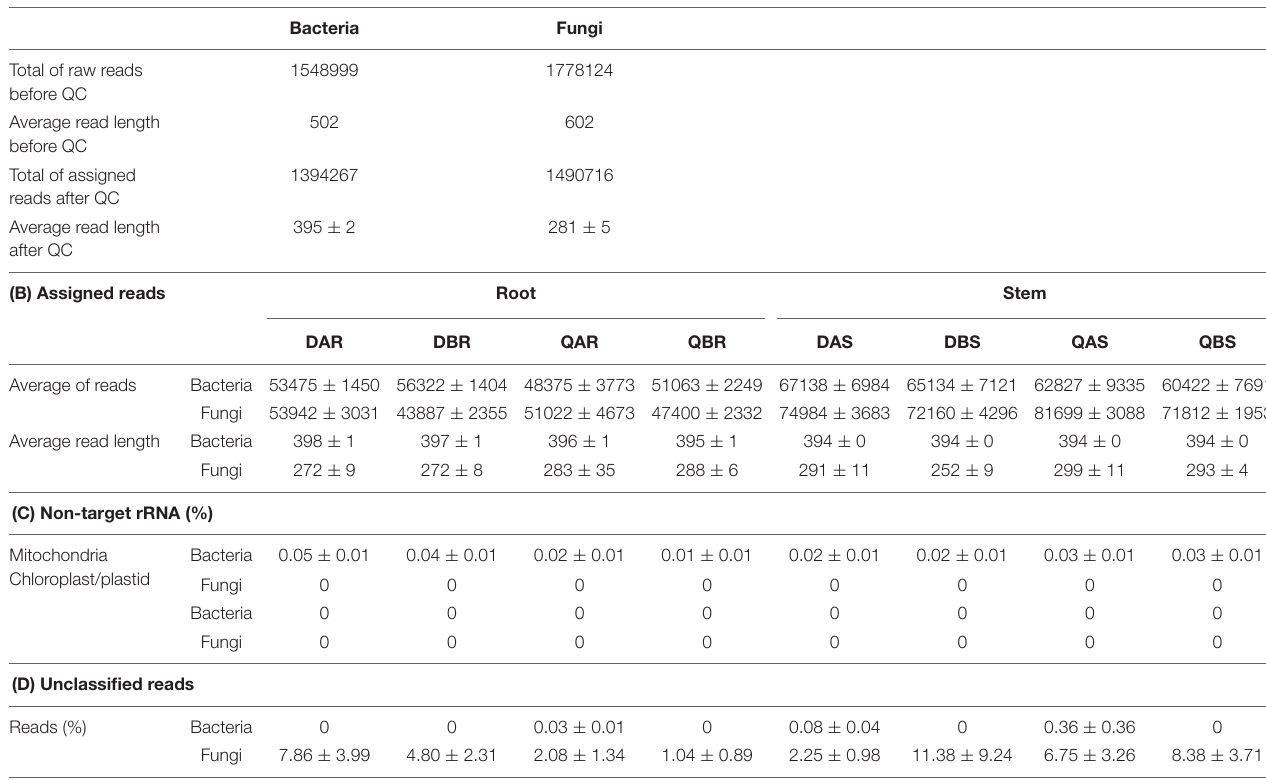
TABLE 1 | Quality metrics of Illumina sequencing